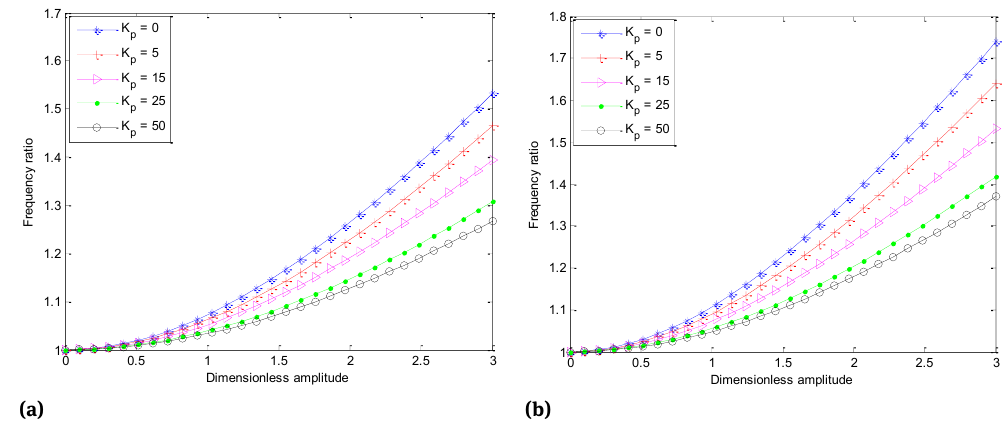
Figure 9: (a) Effects of dimensionless Pasternak elastic medium stiffness on the frequency ratio for simply supported nanobeam (b) Effects of dimensionless Pasternak elastic medium stiffness on the frequency ratio for clamped-clamped supported nanobeam